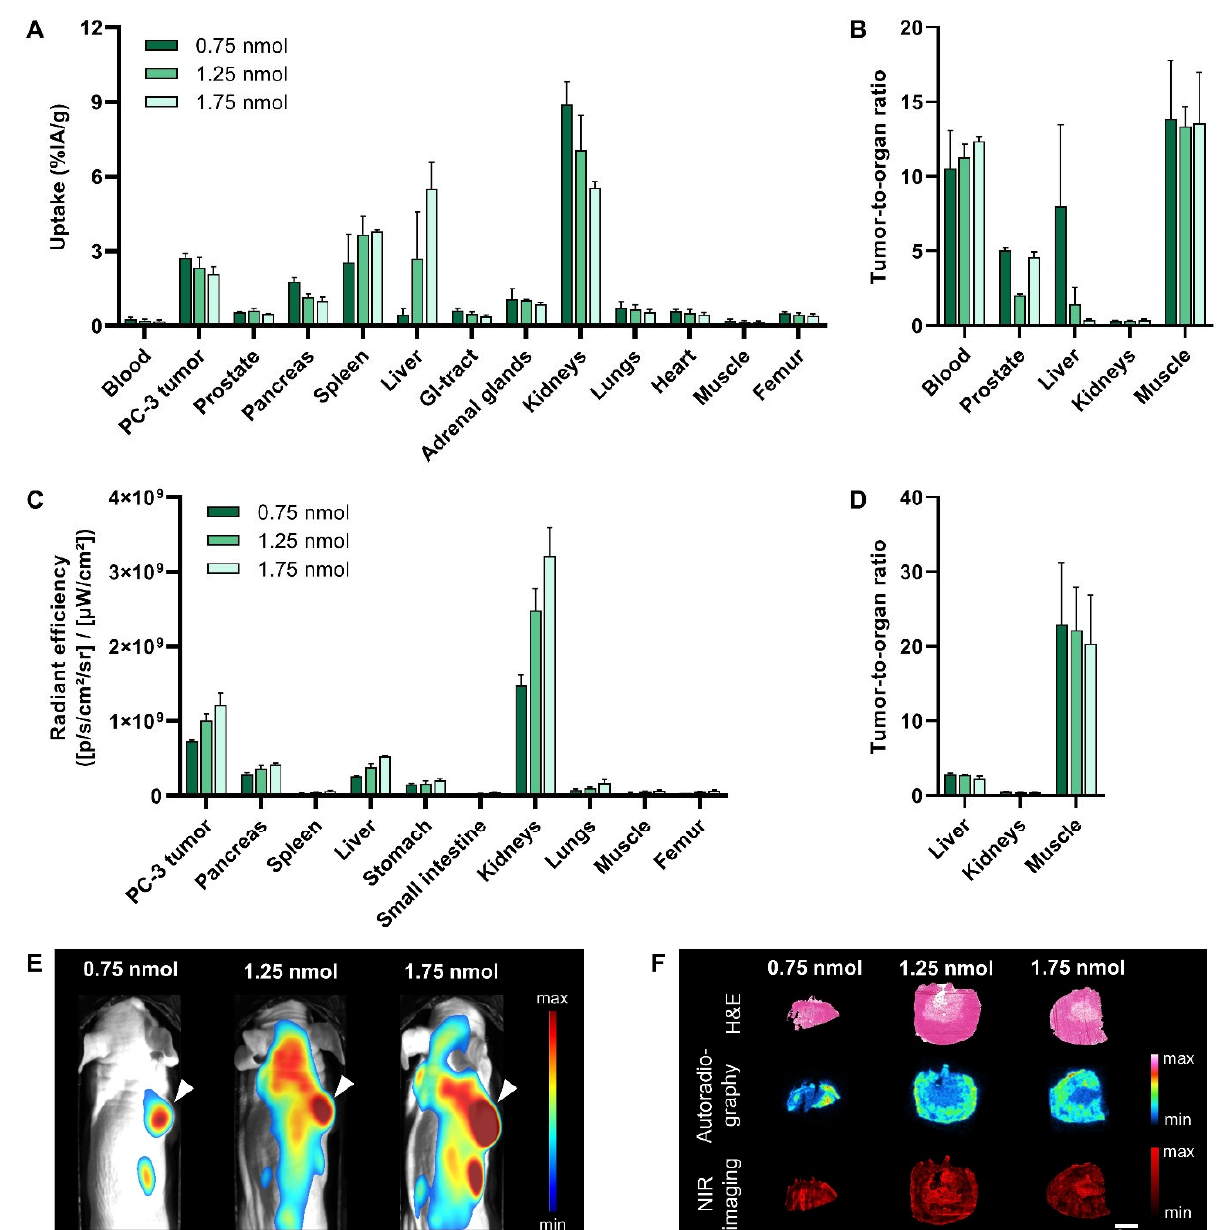
Figure 4. Evaluation of 0.75 nmol, 1.25 nmol and 1.75 nmol [ 111 In]In- 14 (20 MBq per administered dose) in PC-3 xenografted mice at 24 h post injection. Ex vivo biodistribution presented as radioac- tivity uptake (expressed as percentage injected activity per gram of tissue (%IA/g)) ( A ) and the corresponding tumor-to-organ ratios ( B ). Quantification of ex vivo fluorescence imaging of a selection of dissected organs and tissues expressed as average radiant efficiency in p/sec/cm 2 /sr per µW/cm 2 ( C ) and corresponding tumor-to-organ ratios ( D ). Data are presented as mean ± standard deviation ( n = 4). In vivo whole-body optical imaging displayed as merged photographs and fluorescence images ( E ). The arrow head points at the location of the PC-3 tumor. Ex vivo PC-3 xenograft analysis of one representative mouse per group demonstrating the histology (top row), radioactive signal distribution (middle row) and fluorescent signal localization (bottom row) ( F ).